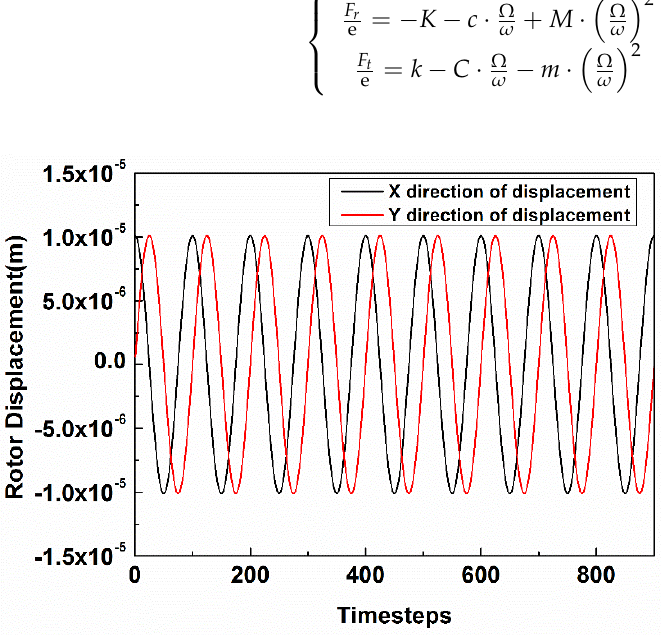
Figure 6. Single-frequency circular vibration displacement of the rotor (PFR = 1).